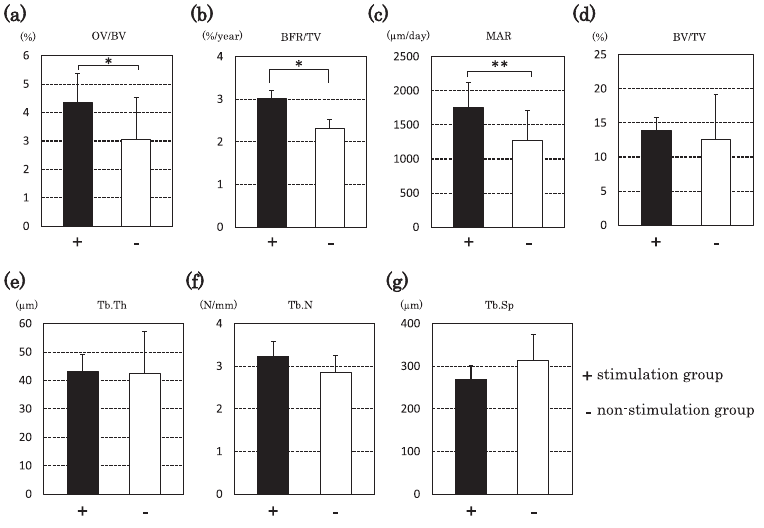
Figure 5 Bone histomorphometry (secondary parameters) Parameters of bone structure are shown. The graphs show results for bone volume-to-tissue volume (BV/TV) ratio, trabecular thickness